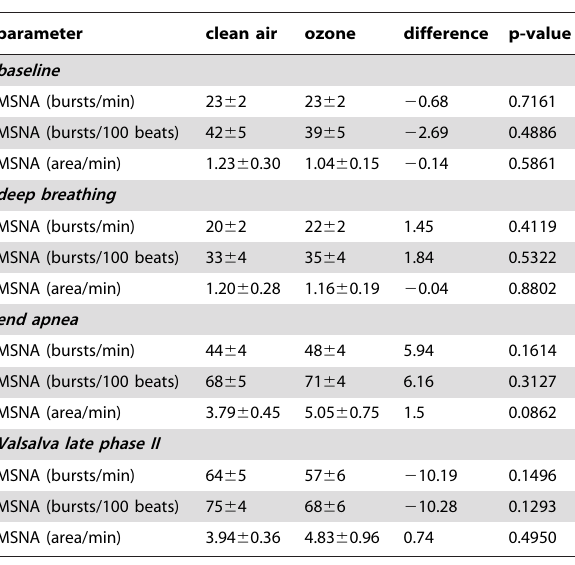
mean values 6 SEM (n=11), MSNA = muscle sympathetic nerve activity.